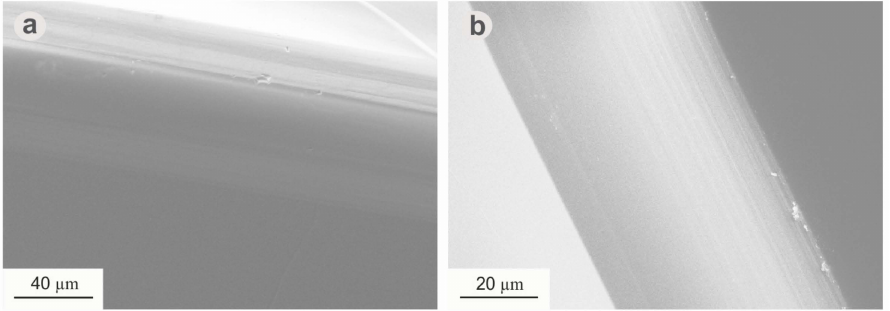
Figure 2. The examples of initial diamond crystal surfaces. Note the absence of any etching sculptures ( a ), except for a slight striation at the edges (( b ), enlarged